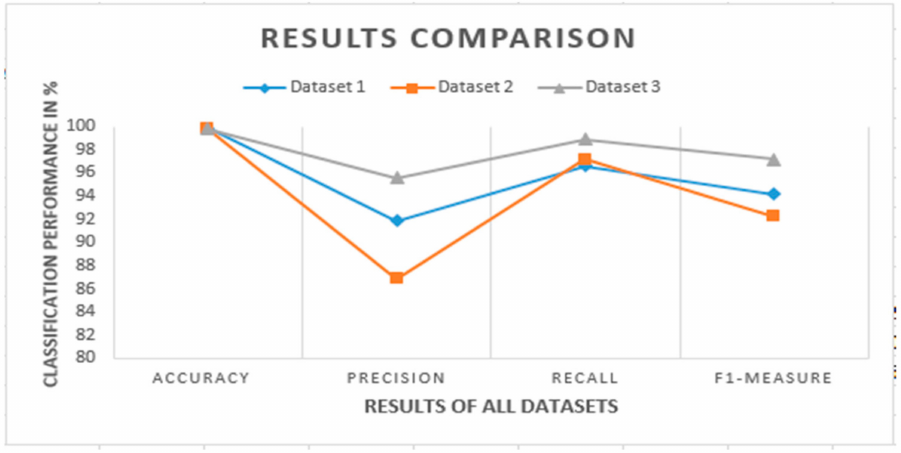
Figure 10. Result comparison of all